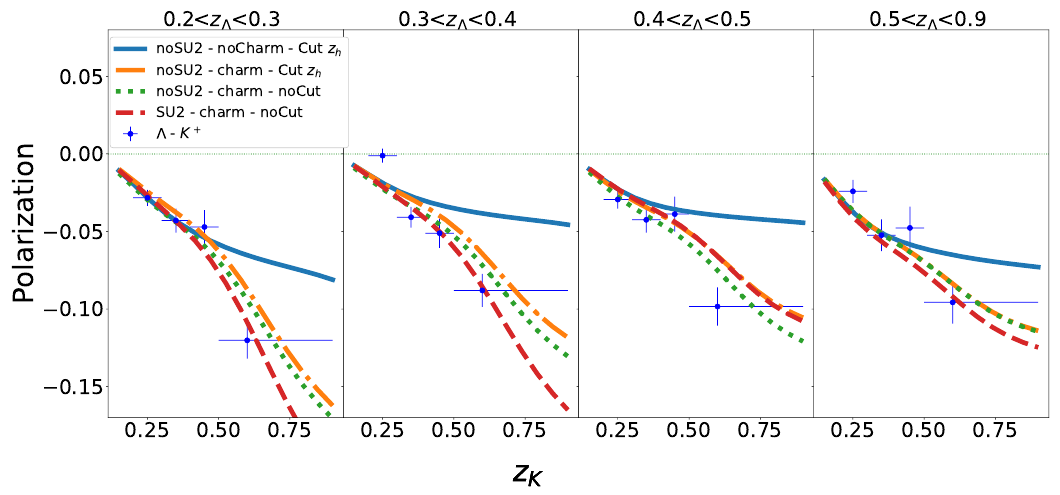
Figure 14 . Impact of SU(2) symmetry, charm contribution and large z K -cut in the description of Λ K + data: without SU(2) sym., no charm and z charm and z cut (orange dot-dashed line), without SU(2) sym., with charm and without z K (green dotted line) and imposing SU(2) sym., with charm and without z